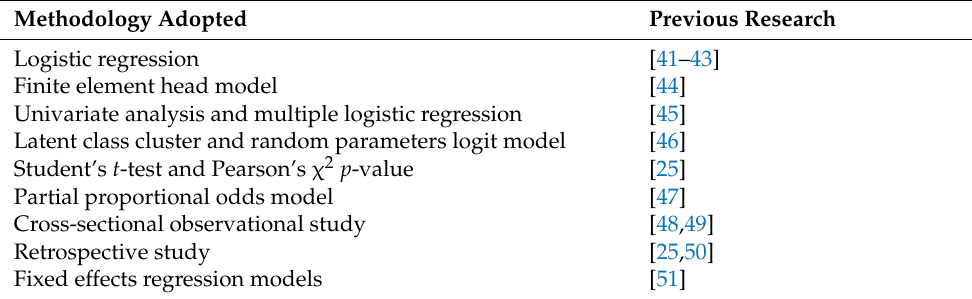
Table 1. Summary of previous methodological approaches used for helmet-wearing and non-helmet- wearing motorcyclists’ injury